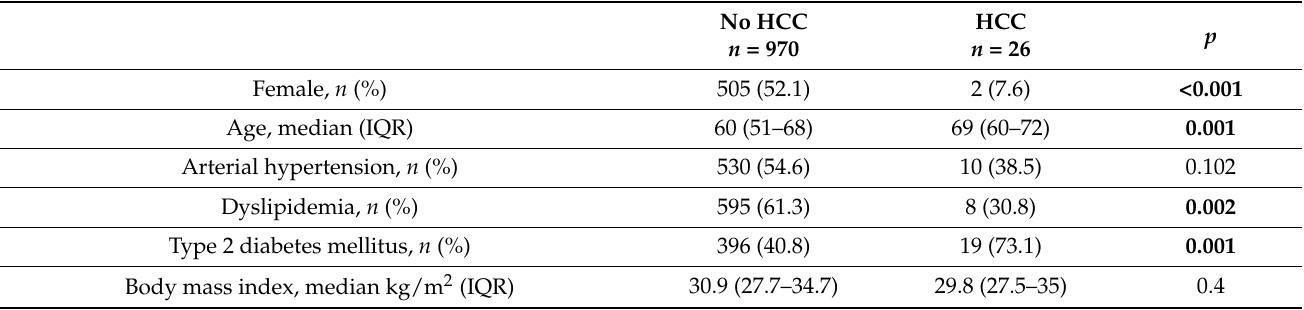
Table 1. Characteristics and outcomes according to the diagnosis of hepatocellular carcinoma (en- tire